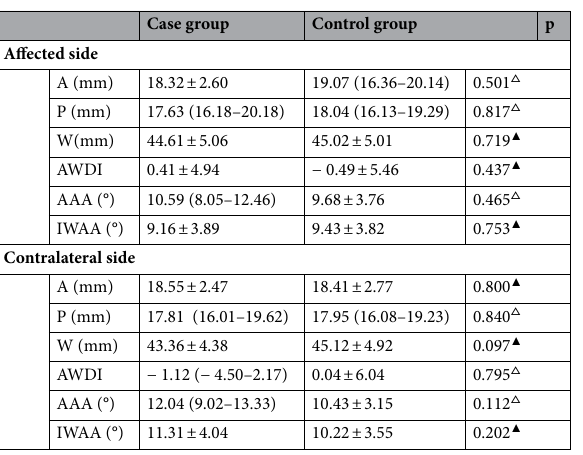
Table 2. Comparison of case group and Control group. “ ▲ ” use independent sample t test. “ △ ” uses Mann Whitney U test. Normal data, described by mean ± SD, non-normal data, described by median